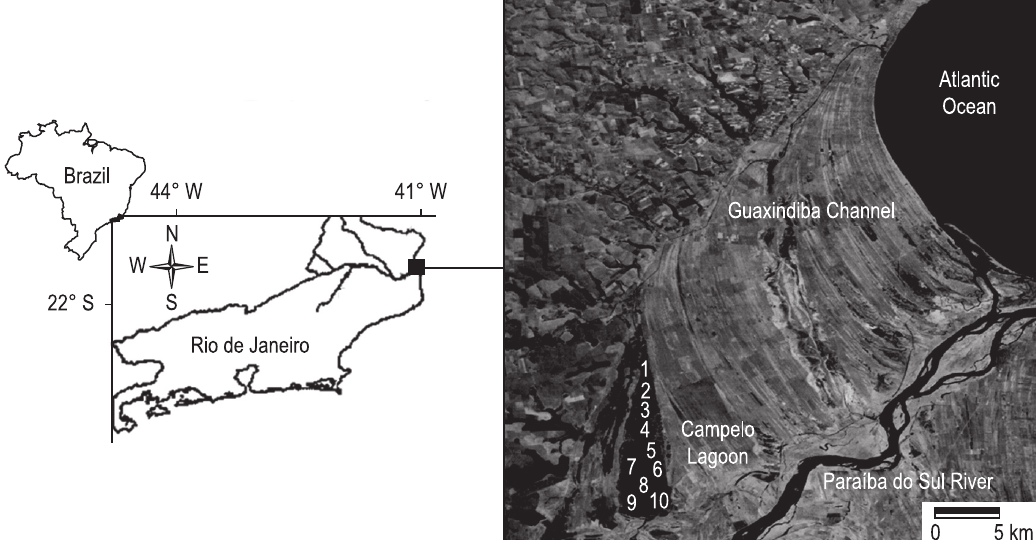
Figure 1. Map of the Campelo Lagoon and 10 sampling sites, State of Rio de Janeiro, Brazil. Source: Landsat